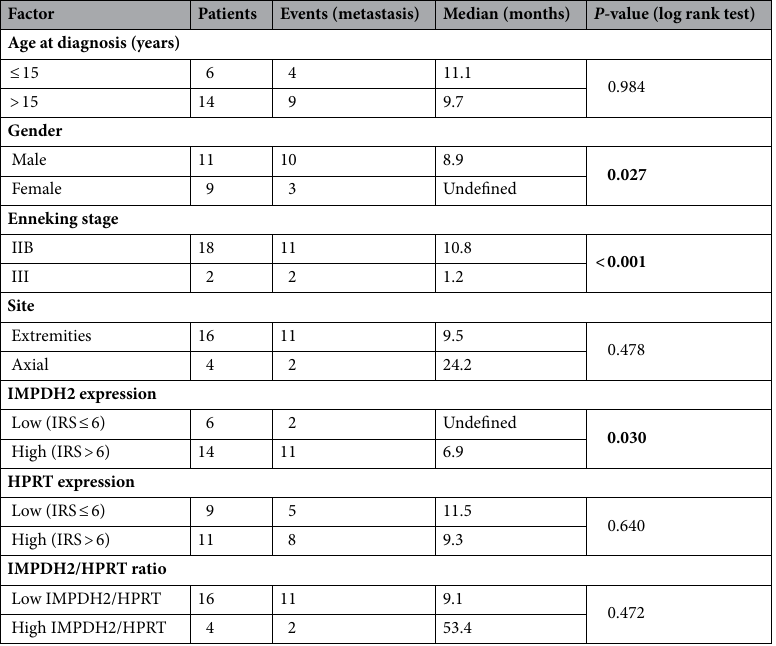
Table 6. Metastasis-free survival analysis (N = 20). P values were calculated using the log-rank test. P values < 0.05 shown in bold.